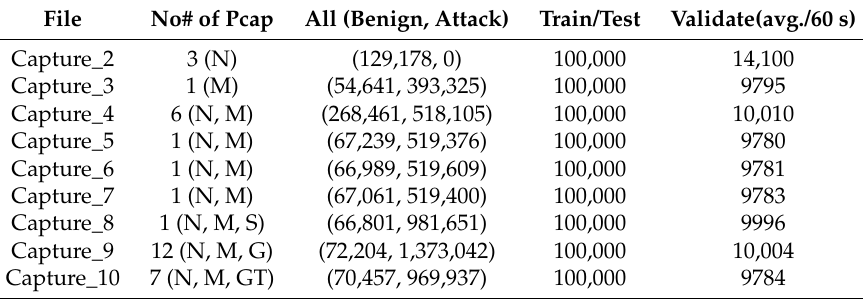
Table 8. Train/Test/Validate traffic proportion in our dataset.